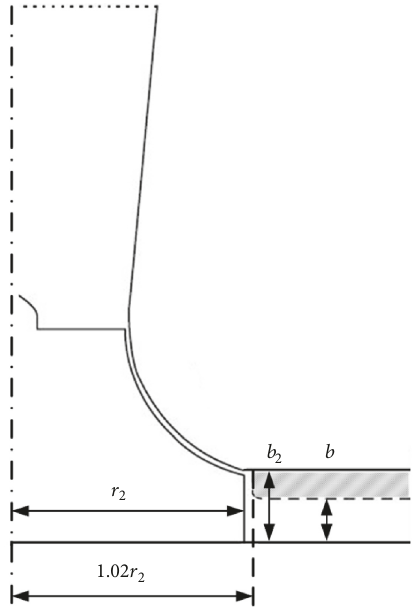
Figure 11: Details of the pinched diffuser.